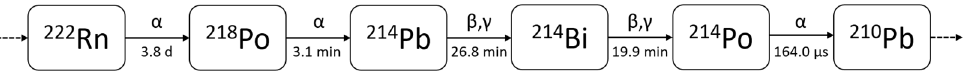
Figure 1. Part of the 238 U decay chain with the relevant nuclides from 222 Rn to 210 Pb with their associated decay modes and half-lives [2] .